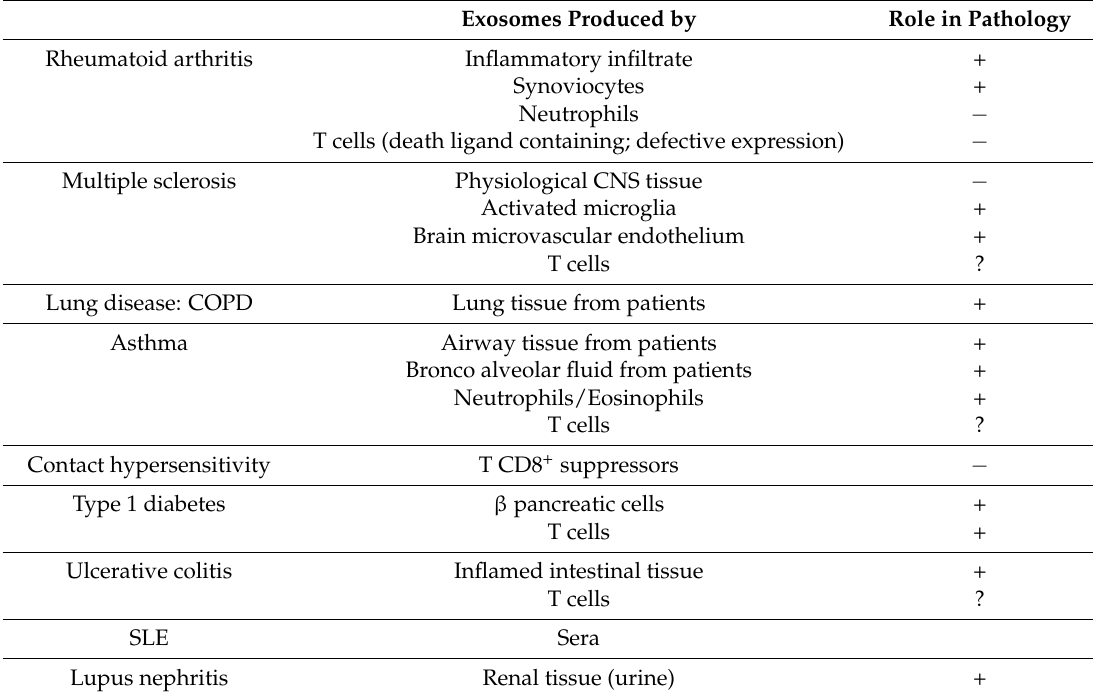
Table 1. Summary of the role of exosomes, depending on their procedence, on the development of the pathology indicated. +, exosomes favor pathology development; − , exosomes alleviate the pathology; ?, not